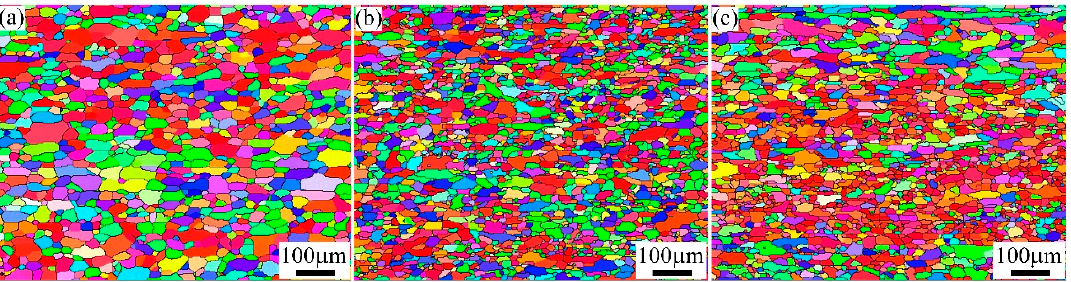
Figure 5. Recrystallized structure of A1, A2, and A3 alloys after solution treatment: ( a ) A1 alloy, ( b ) A2 alloy, and ( c ) A3 alloy.